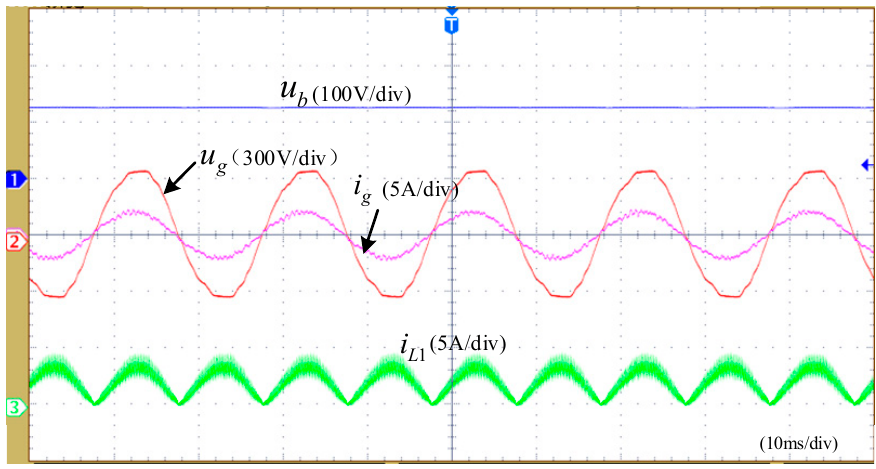
Figure 9. The experimental waveform of the presented converter operating in charging mode under unity power factor ( P = 400 W, Q = 0 var, cos ϕ = a unity power factor ( P = 400 W, Q = 0 var, (cid:1855)(cid:1867)(cid:1871)(cid:2030) = 1 ).